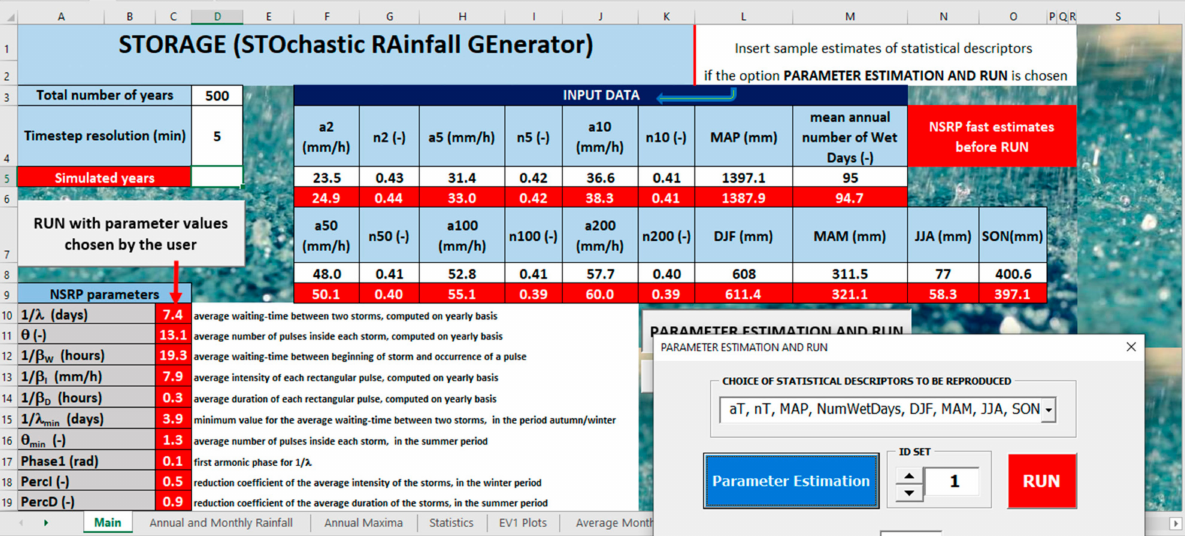
Figure 7. Example of calibration results in the Main